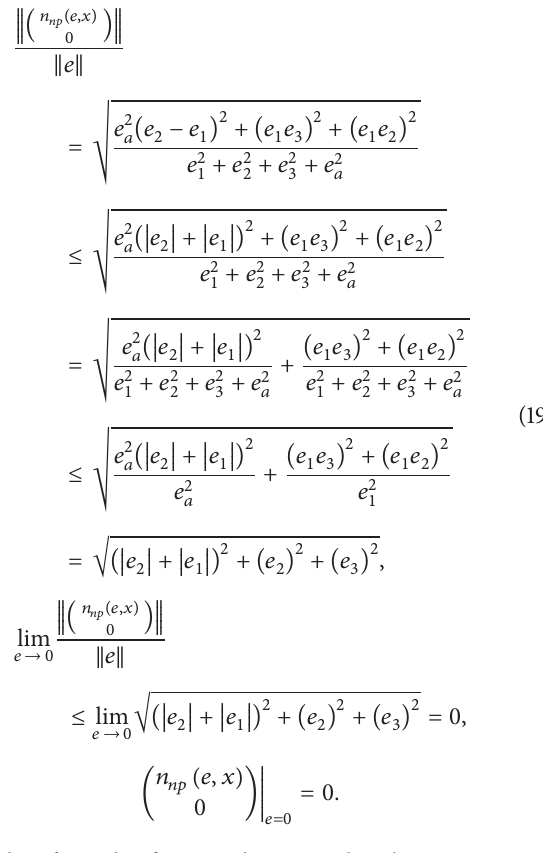
𝜆 = −8/3 , and − max [ Re 𝜆 ( 𝐿+𝐹 4